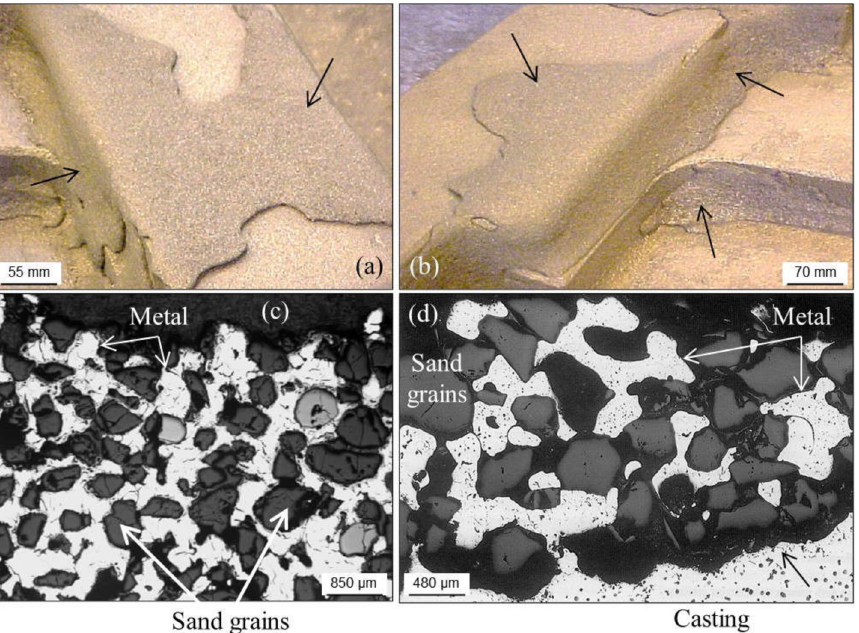
Figure 17. Conventional metal penetration (no marked chemical reaction) in a heavy-section casting manufactured in chemically bonded sand mold ( a , b ); microscopic view of the layer in two different locations ( c , d ).